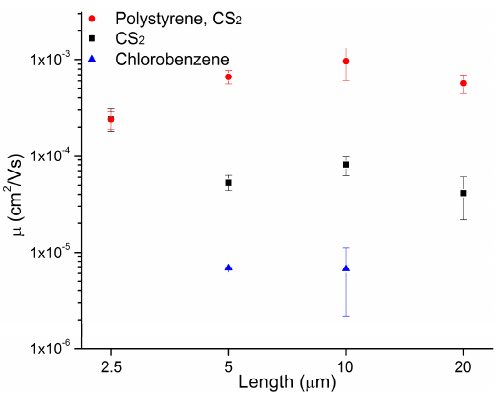
Figure 2. Comparison of average mobilities for 1 devices prepared using chlorobenzene, CS 2 and a poly(styrene)/CS 2 blend. All data is for devices tested in air. Working devices were not obtained for the 2.5 and 20 µm channels for the chlorobenzene sample.